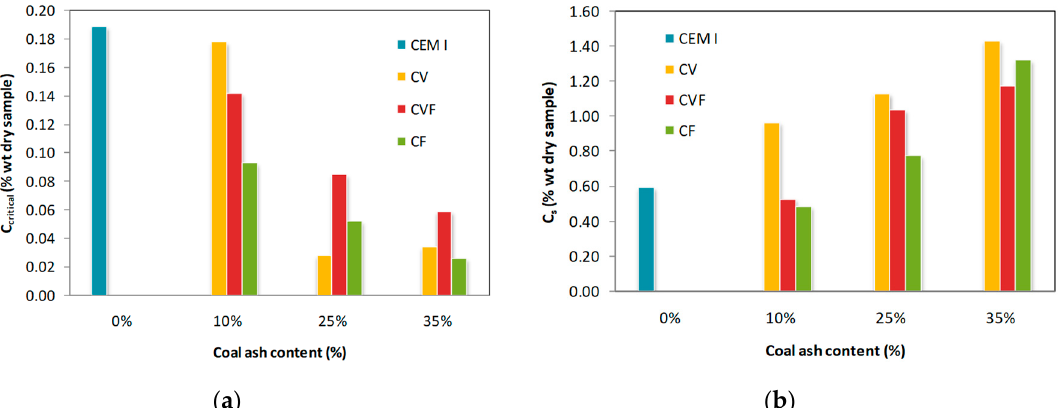
Figure 3. Critical ( a ) and surface ( b ) chloride content in the function of the coal ash content after testing.